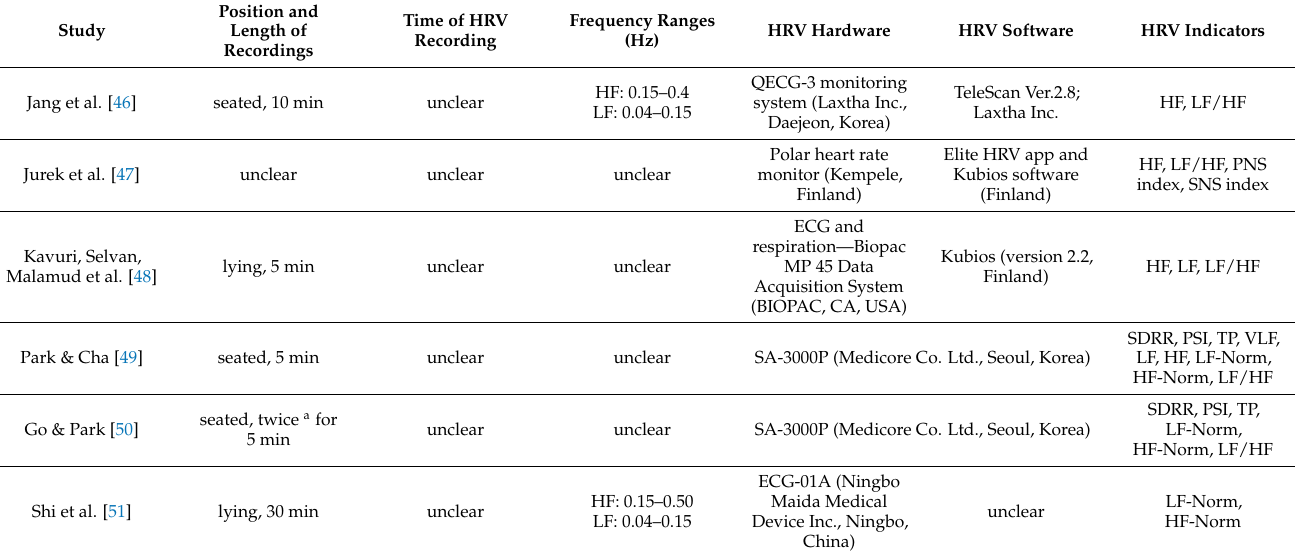
Table 3. Methodology of HRV